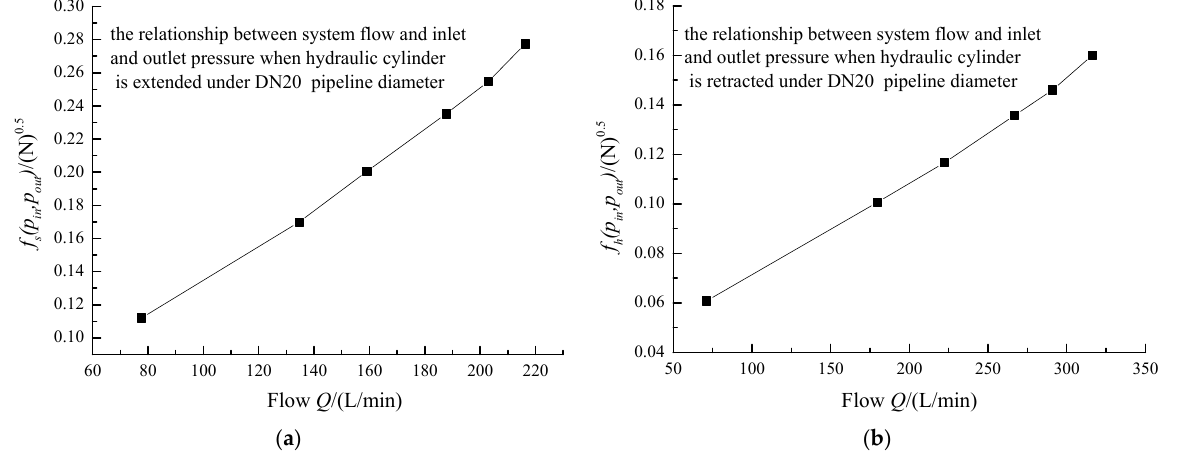
Figure 12. Relationship between flow and inlet and outlet pressure of hydraulic cylinder under DN20 diameter: ( a ) extended; ( b ) retracted.